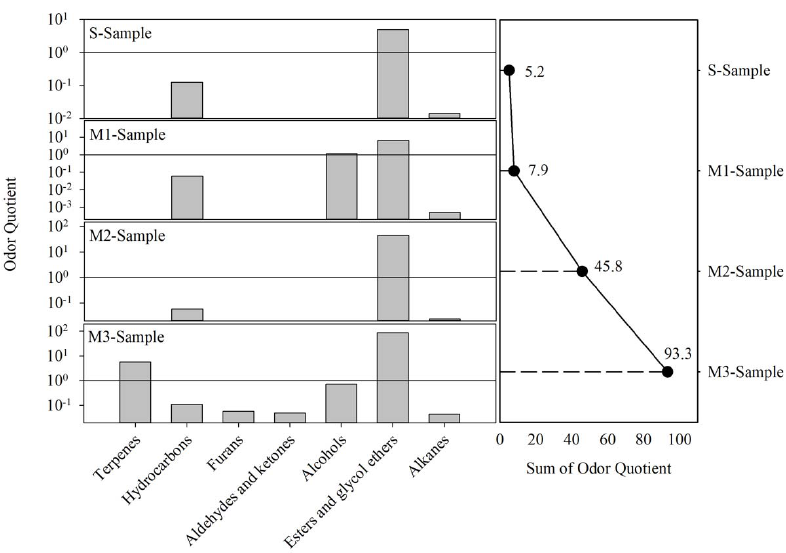
Figure 5. Distribution of odor quotients for each chemical group (bar graph, left side) and sum of odor quotient for each sample in the field study (line graph, right side) for four different sampling conditions (Table 1). Odor quotients were calculated as the ratio of the measured concentrations at headspace gas to the odor threshold concentrations. Odor quotient is 1 when humans begin to sense the odor from a specific substance.